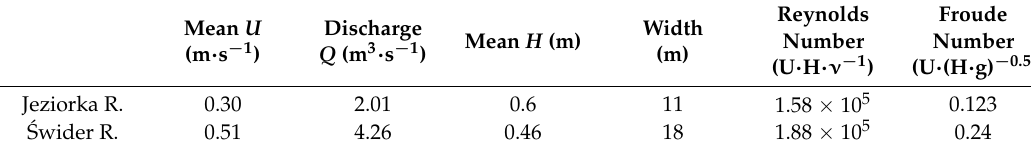
Table 1. Basic hydraulic statistics of the studied rivers in the experimental